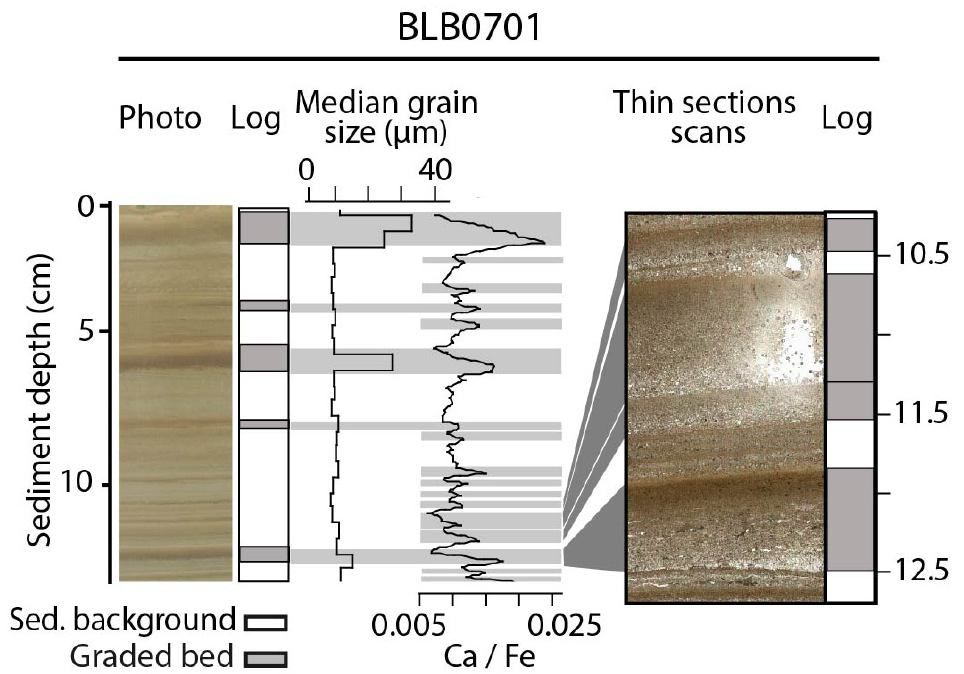
Figure 4. Flood deposits in the detrital-rich Lake Blanc (BLB) sedimentary sequence. Given the strong dominance of detrital matter, the contrast of composition between the sedimentary background and graded layers resulting from for example flood events is low and the grain size is the best parameter to distinguish the two types of deposits. The high-resolution geochemical proxy (Ca/Fe) of grain size allows the identification of mm-scale graded layers, also found from thin section observations, but not from classical grain-size measurements (modified after Wilhelm et al. [41]).